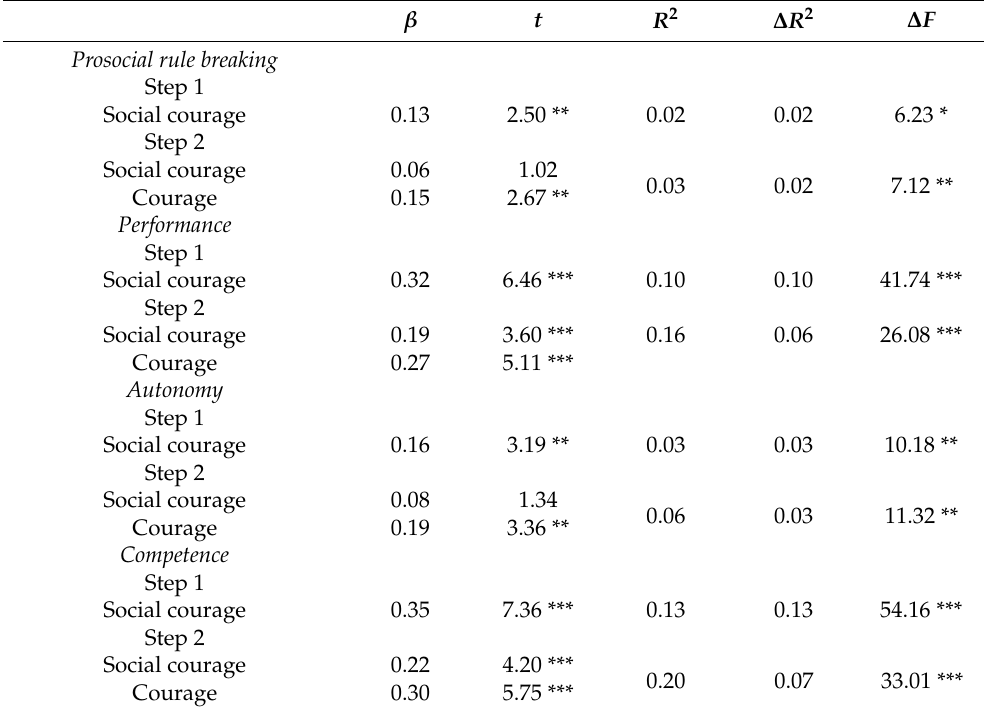
Table 8. Hierarchical regression